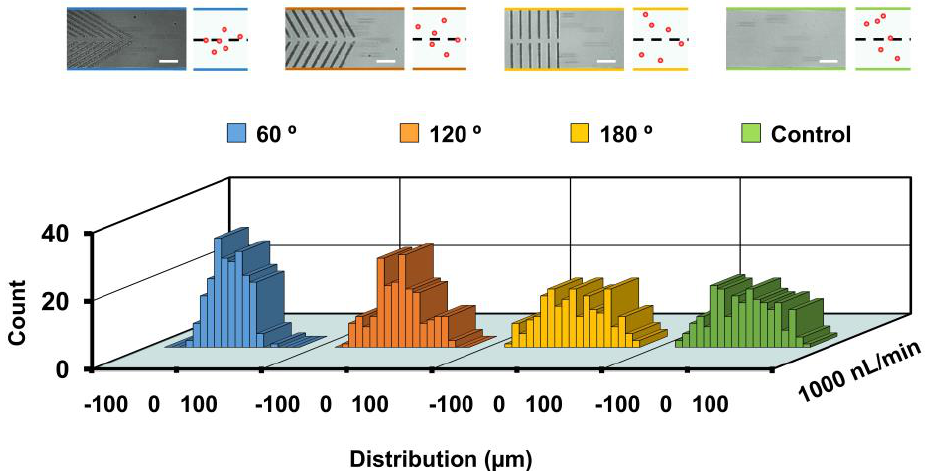
Figure 4. Particle focusing performance affected by groove angle. Distributions of 15- µ m polystyrene particles at the end of block 1. Superimposed experimental images and schematics are shown at the top. Two hundred particles are measured for each group. Scale bar is 60 µ m.